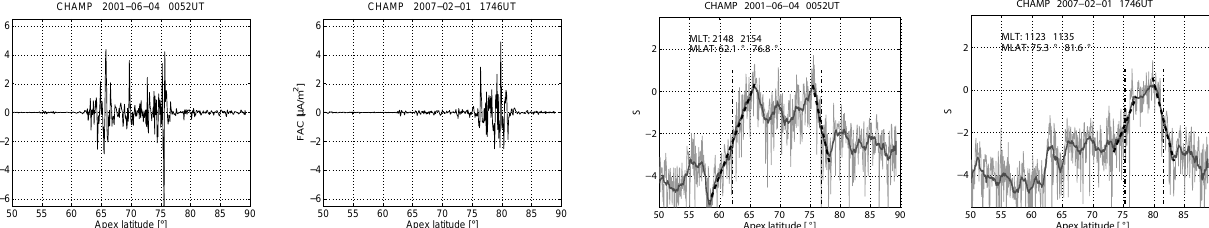
Fig. 2. Boundaries (dashed-dot lines) of the auroral oval for the two examples of CHAMP FAC signatures as shown in Fig. 1. For the detection approach see text.